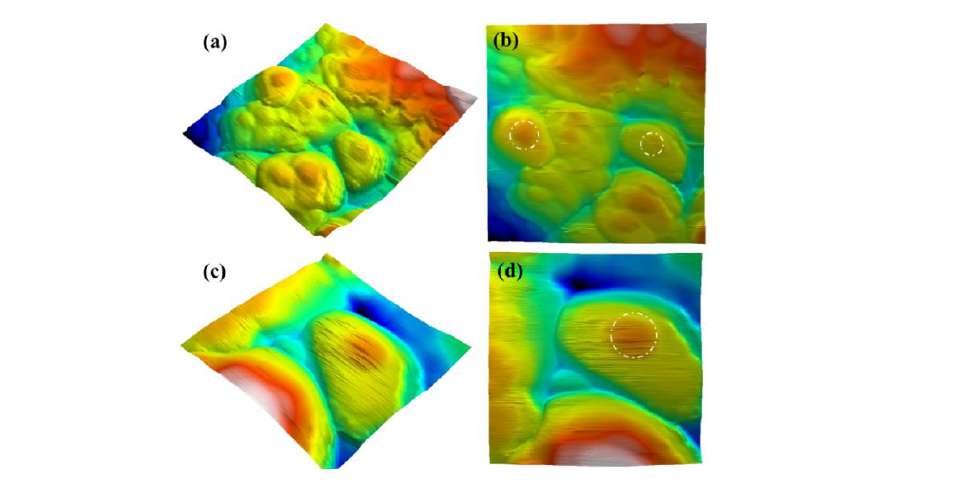
Figure 7. AFM images of the core – shell Au@TiO 2 material; ( a , c ) 3D images and ( b , d ) plane images.